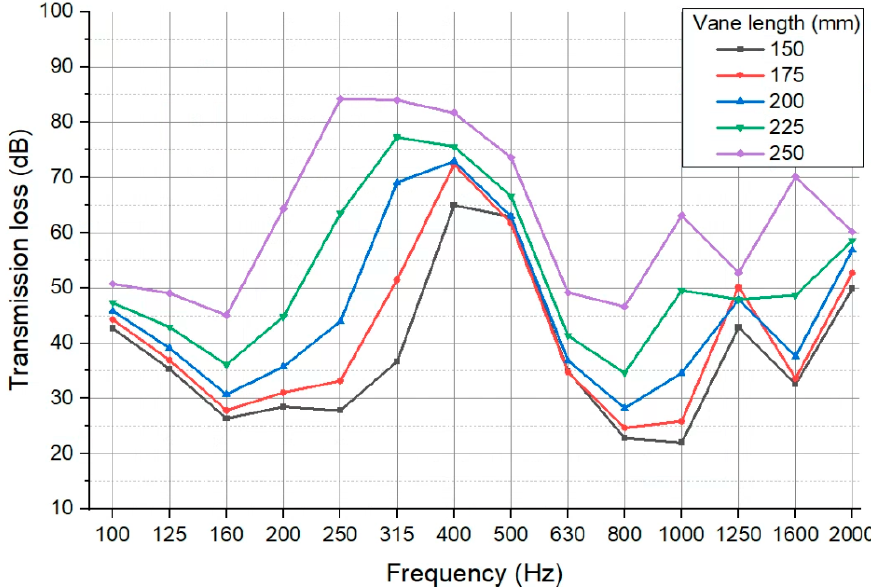
Figure 16. Transmission loss according to the vane length in the outer vane type.